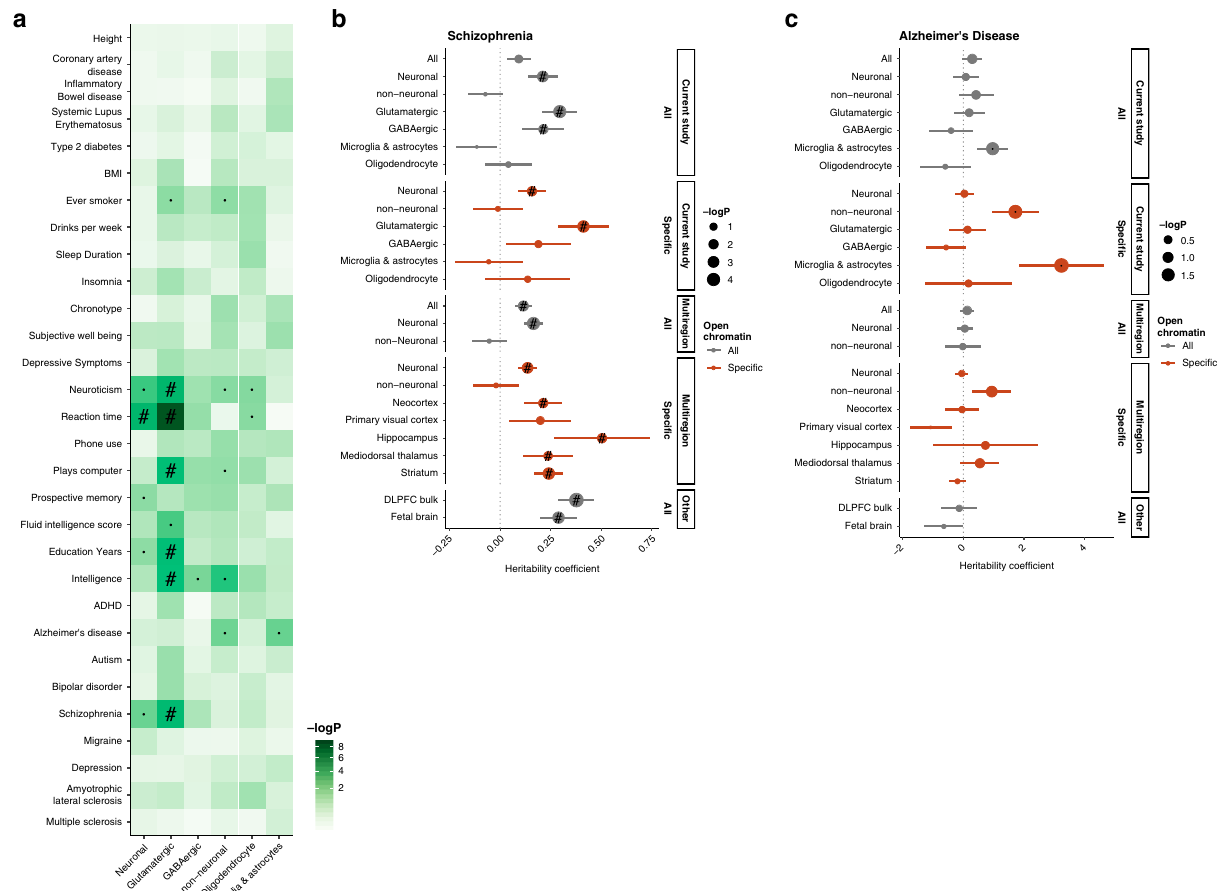
Fig. 5 Overlap of OCRs with trait- and disease-associated genetic variants. a P -value for enrichment of trait-associated genetic variants in cell-speci fi c OCRs. The heritability coef fi cient of genetic variants overlapping different sets of OCRs in ( b ) SCZ and ( c ) AD. Positive coef fi cient signi fi es enrichment in heritability. “ Multiregion ” was our previous study of neuronal and non-Neuronal cells across multiple regions of the adult human brain. The region-speci fi c OCRs are neuronal, as only neuronal cells showed a marked region variability. In all cases, the overlap was assessed using LD-score partitioned heritability where the OCRs were padded with 1000bp to also capture adjacent genetic variants and corrected for the general genomic background. ” # ” : Signi fi cant for enrichment in LD score regression after FDR correction of multiple testing across all tests in the plot (Benjamini & Hochberg); ” · ” : Nominally signi fi cant for enrichment; DLPFC: dorsolateral prefrontal cortex. Error bars indicate standard errors from LD score regression using respectively 1,021,224 and 1,034,664